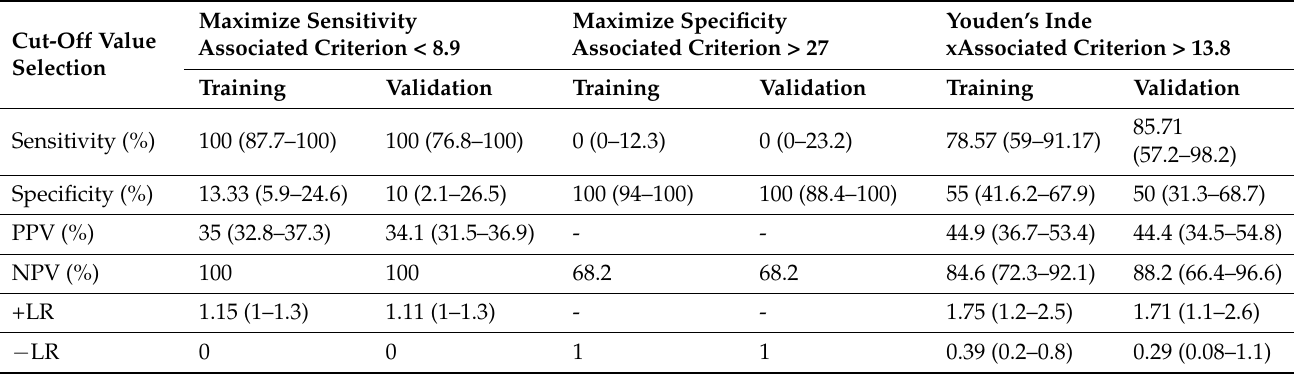
Table A1. The points of ROC curve model for values of E/e’ ratio according to rehospitalization for a first episode of acute HFpEF within the first 6 months after the first admission, for both the training cohort and the validation contingent. Cut-Off Value